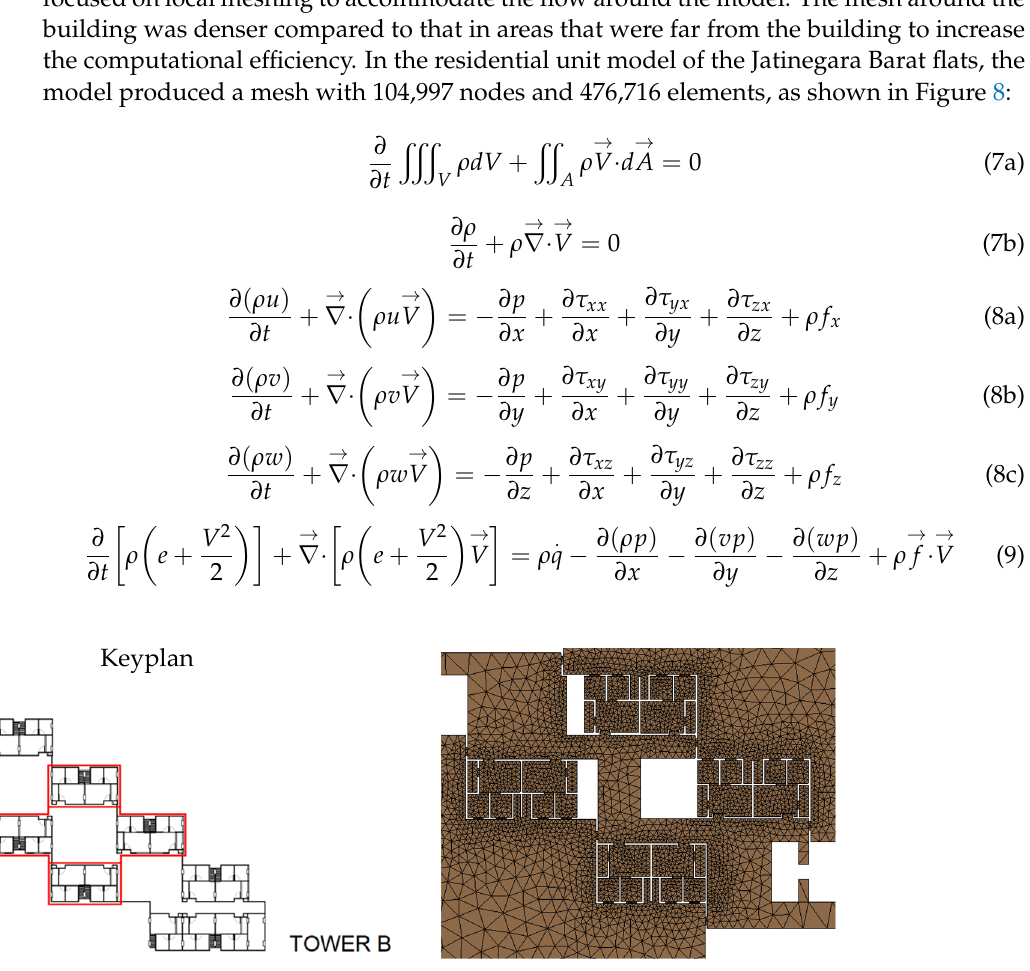
Figure 8. Local meshing at tower B as a depiction of the local meshing in the simulation.